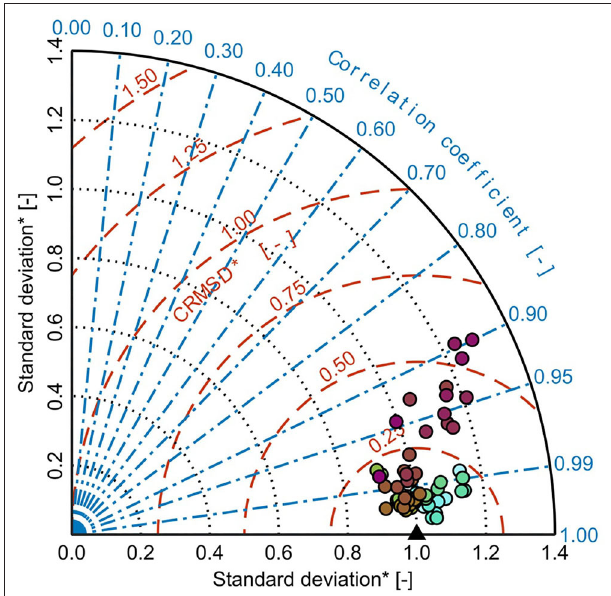
FIGURE 3 | Model performance according to the Taylor diagram, using the standard deviations, Pearson correlation coefficients, and CRMSDs. The spring-neap cycle from September 28 to October 13, 2012, was used for the calculation of statistical parameters. Quantities that were normalized by the standard deviations of the observational data are indicated by *. The black triangle indicates a perfect model fit. The color codes and locations of tidal gauges are shown in Figure 1 .